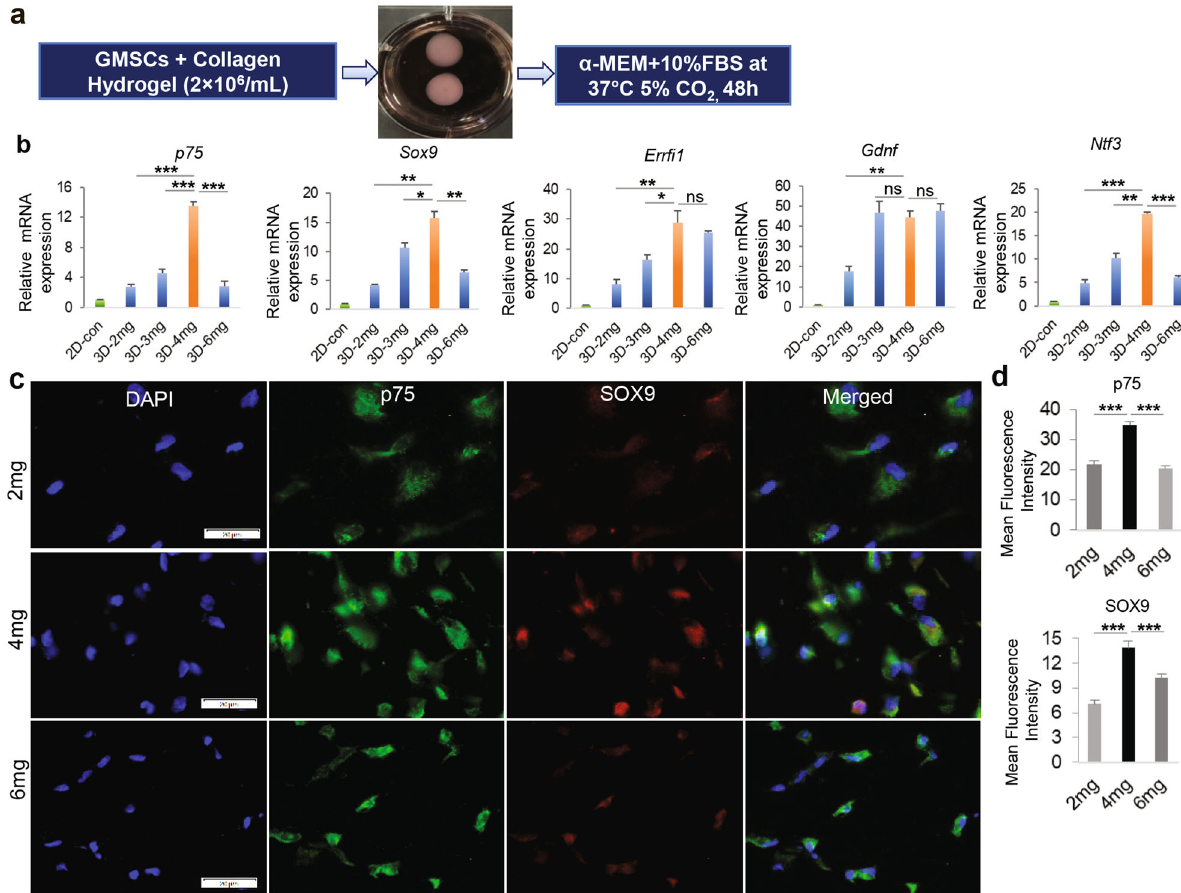
Fig. 1 Upregulation of NCSC/SCP-related genes in GMSCs cultured in methacrylated 3D-collagen hydrogel. a GMSCs (2 × 10 6 /mL) were encapsulated in 3D-collagen hydrogel at different concentrations (2, 3, 4, 6 mg/mL) and cultured in complete α -MEM for 48 h. b The expression levels of Ngfr (p75), Sox9 , Err fi 1 , Gdnf , and Ntf3 in GMSCs cultured in 3D collagen hydrogel were determined by qRT-PCR as compared to those in 2D-cultured GMSCs (2D-con). c Immuno fl uorescence (IF) staining against p75 (green color) and SOX9 (red color) in cryosections of 3D-collagen hydrogel encapsulated with GMSCs. Nuclei were counterstained with 4 ′ , 6-diamidino-2-phenylindole (DAPI; white or blue). Scale bar = 20 µm ( c ). d Quanti fi cation of IF intensity of p75 and SOX9. Data represented the mean ± SD, n = 3 biological replicates. * p < 0.05; ** p < 0.01; *** p < 0.001; ns, no signi fi cant; one-way ANOVA with the Tukey ’ s post test ( b , d ). 2D-con, GMSCs cultured in 2D-conditions; 3D, GMSCs cultured in 3D-collagen hydrogel with different